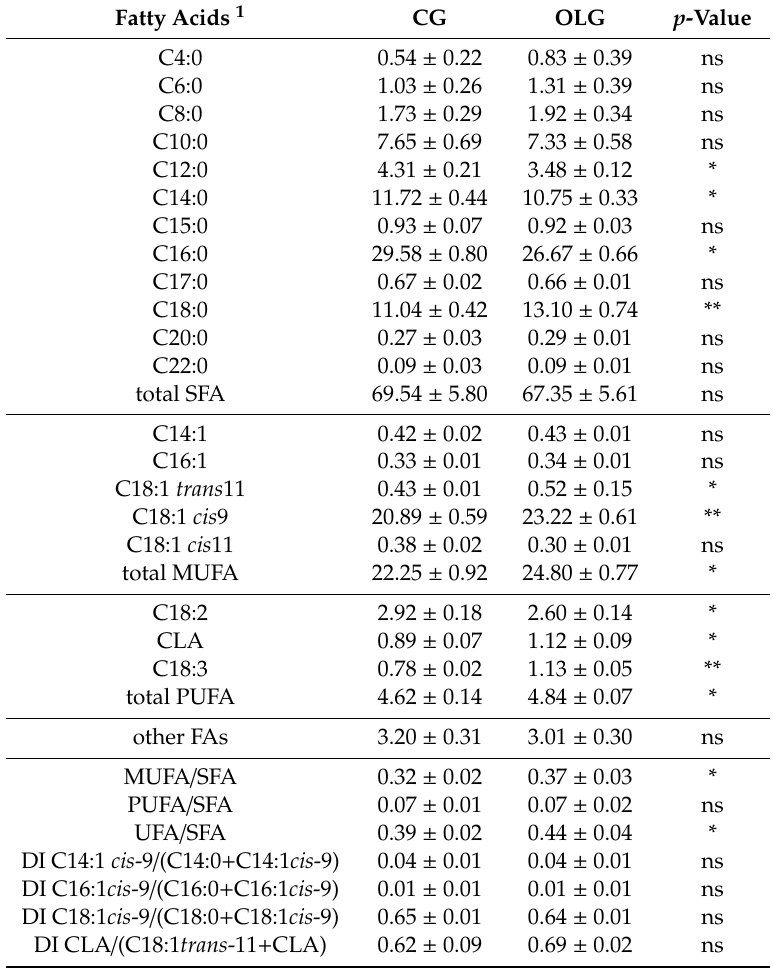
Table 1. Fatty acid composition of yogurt samples obtained from goats fed a standard diet (CG) and goats fed a dietary supplementation of olive leaves